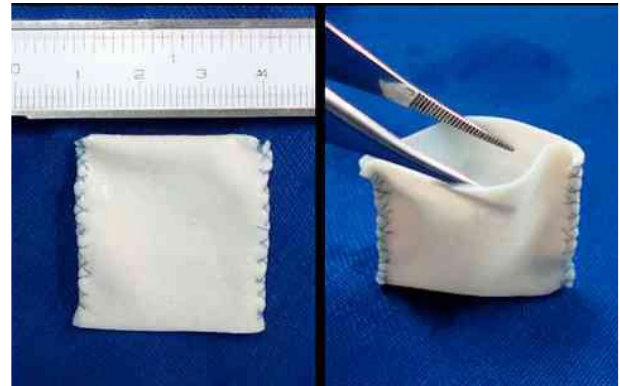
Fig. 1 – 3 x 3 cm bovine pericardial sac for creating the aortic aneurysm.